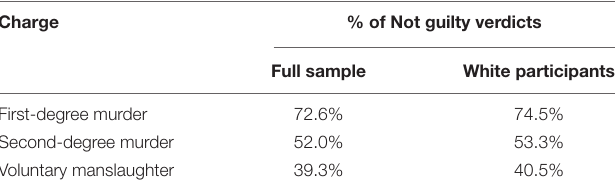
TABLE 1 | First-degree murder verdicts by defendant race and expert testimony.